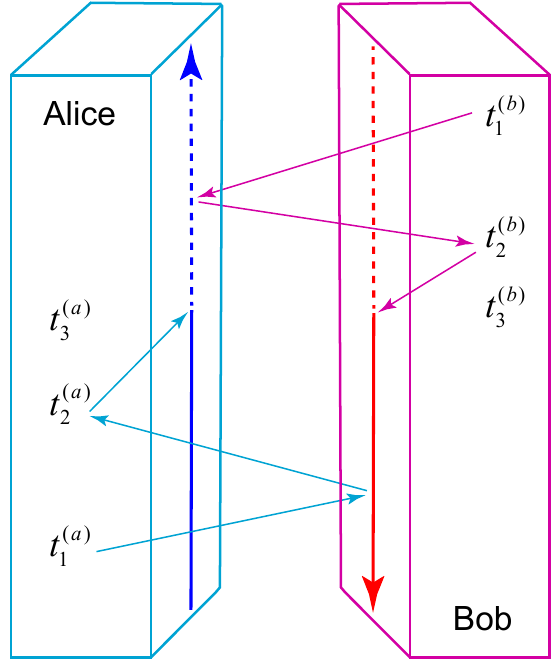
Figure 1: An illustration of the two labs gedanken experiment with two free agents, Alice and Bob. The Causal Paradox is obvious: The dotted blue world- line represents an absent message. How, then, could Bob reply to a message which was removed before he was supposed to see